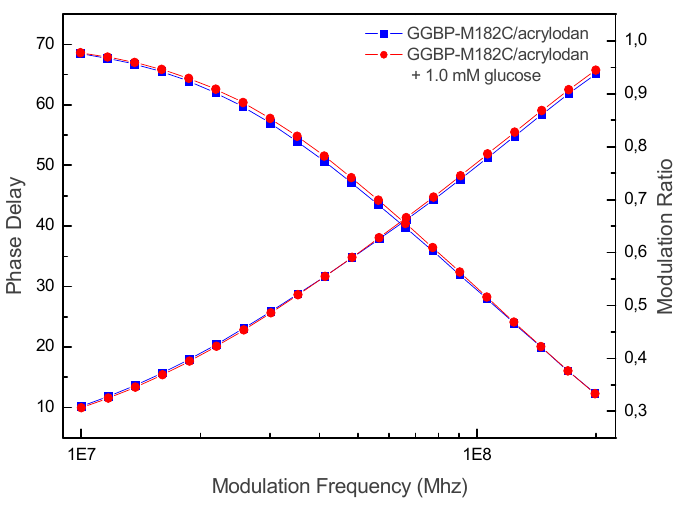
Figure 4. Real-time measurements of glucose concentration by using